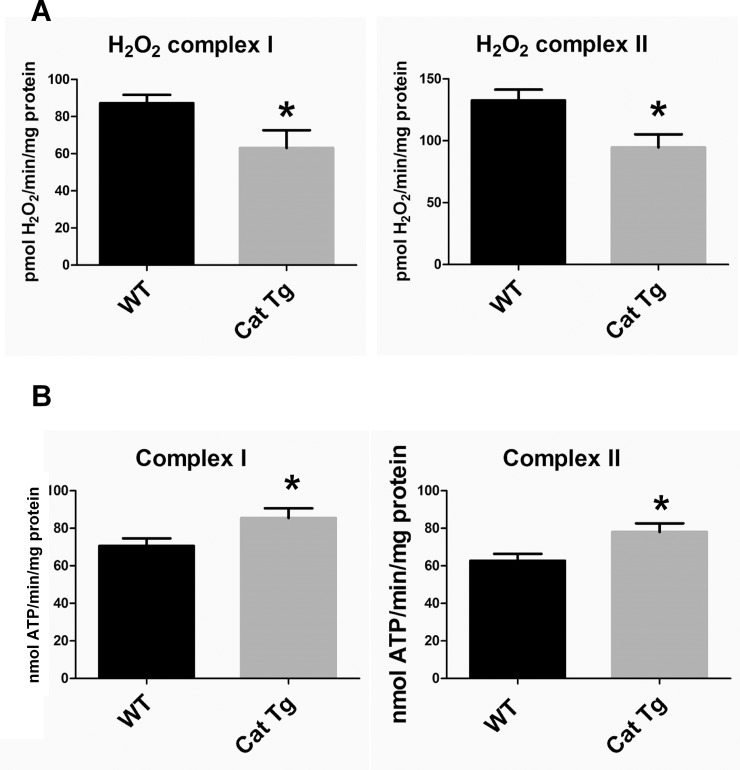
Cardiac mitochondrial H2O2 production and ATP synthesis rates in Cat Tg mice.(A) H2O2 production rates with a complex I substrate (5 mM pyruvate + 5 mM malate) and with a complex II substrate (5 mM succinate and inhibitor of reverse electron transport 2 μM rotenone); (B) Complex I (5 mM pyruvate + 5mM malate) and complex II (5 mM succinate + 2 μM rotenone) substrate-driven ATP synthesis rates. Data represents means ± SEM; N = 5–7; * P<0.05.